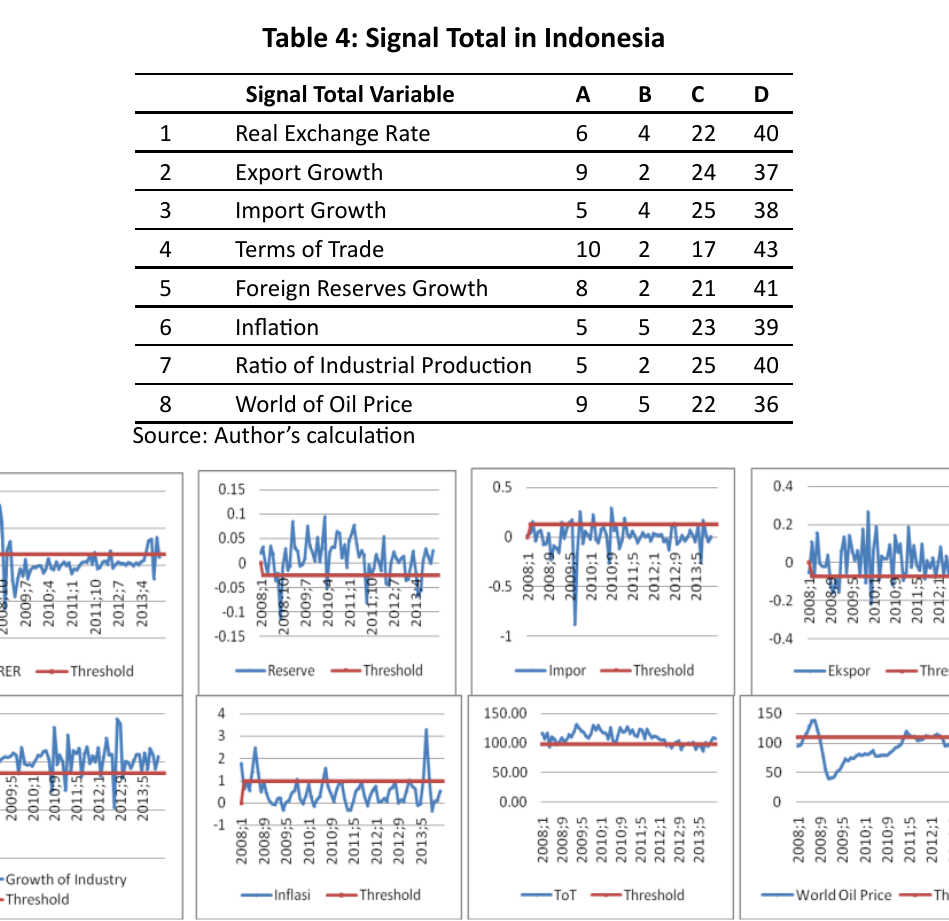
Figure 3: Indicators and Threshold